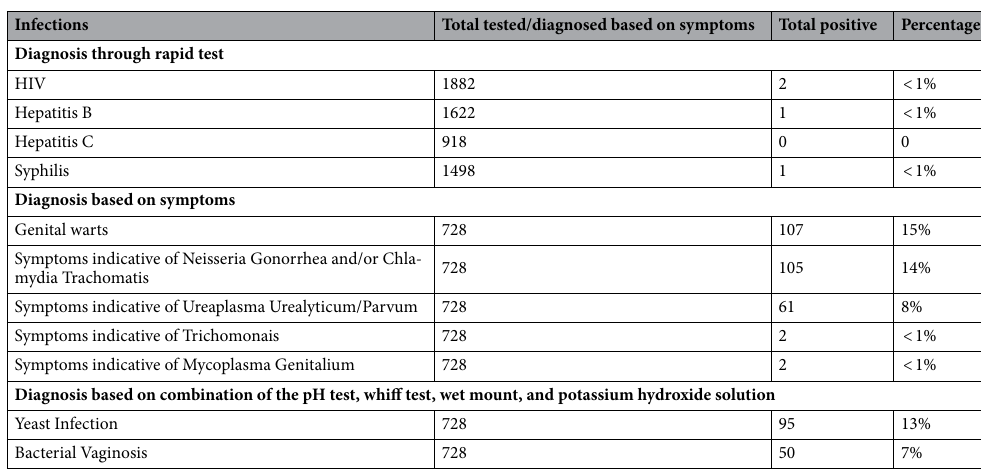
Table 2. Prevalence of STIs and other infections in 2083 women in Lebanon.